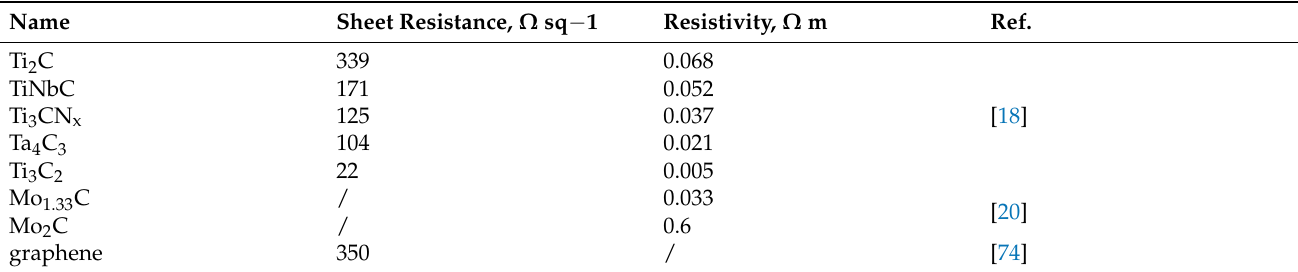
Table 2. Resistivity of some MXenes and